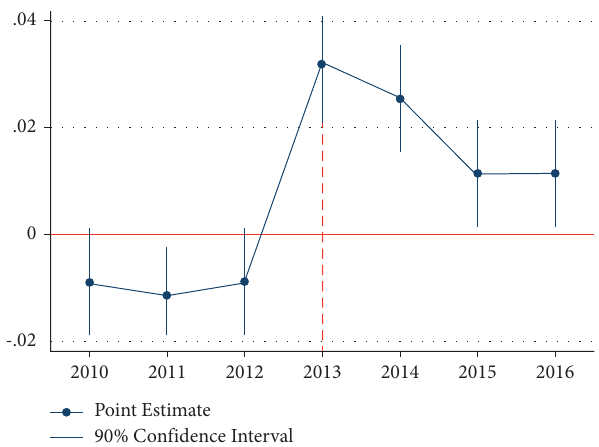
Figure 5: Interaction coefficients in different